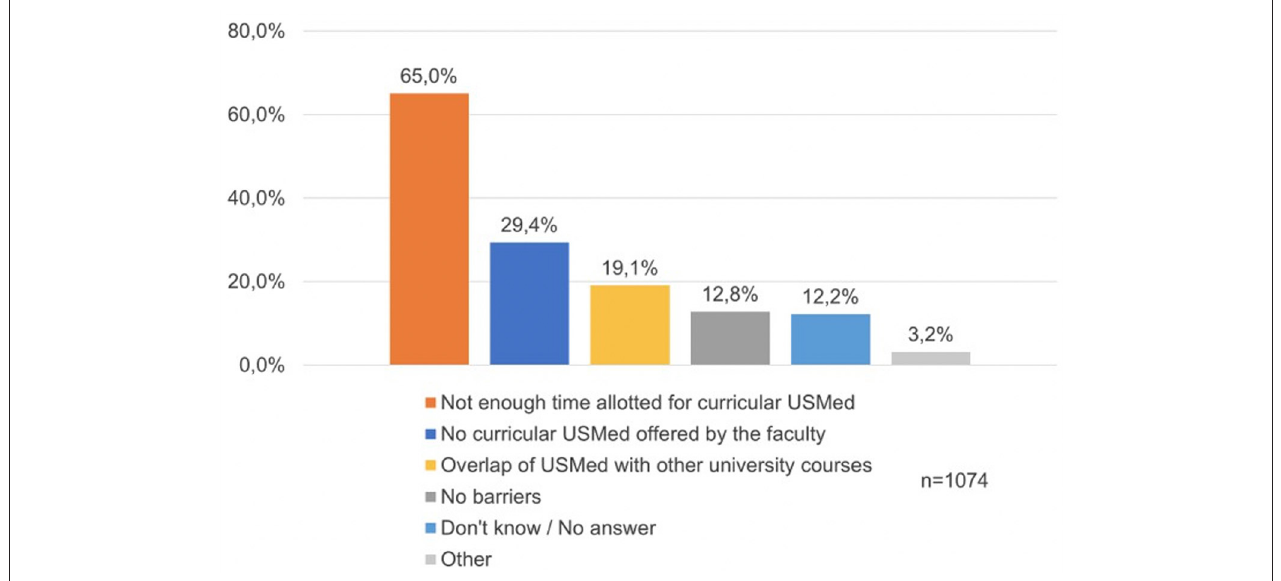
FIGURE 3 | Perceived barriers for ultrasound in medical education at German medical faculties. Numbers are given as